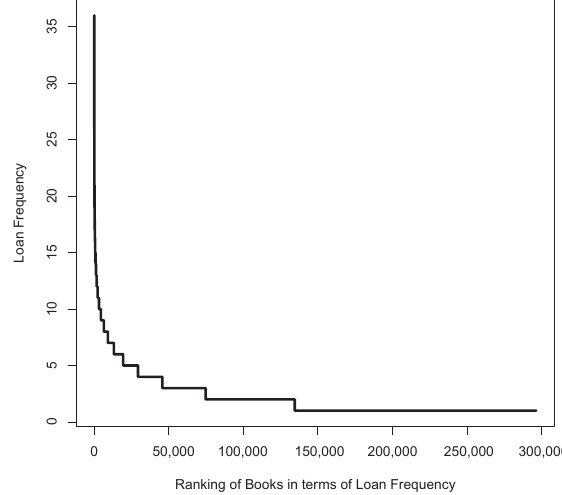
Figure 1. One-year loan frequency of books arranged in descending order, where the book loan data of year 2010 were used.